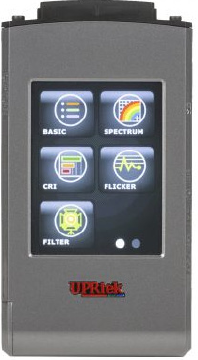
Figure 4. Experimental light source measuring equipment UPRtek MK350N PLUS.